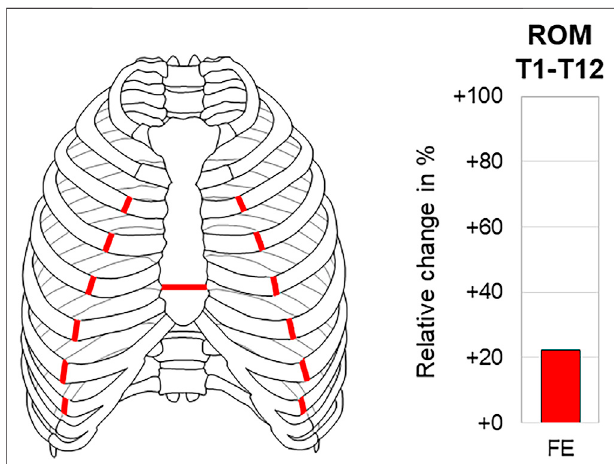
FIGURE 8 | Sternal release. The relative range of motion (ROM) change of the thoracic spine (T1 – T12) in fl exion/extension (FE) after sternal release according to Horton et al.